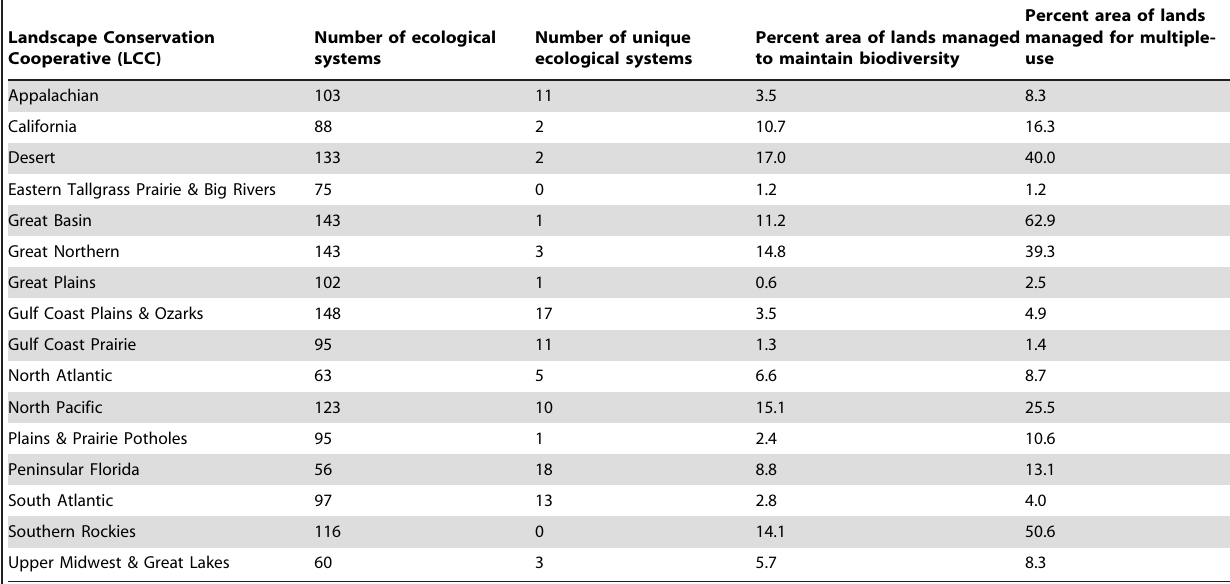
Table 2. Total number and unique number of ecological systems as well as percent area of ecological systems on lands managed to maintain biodiversity and for multiple-use within each Landscape Conservation Cooperative (LCC) in the continental US.